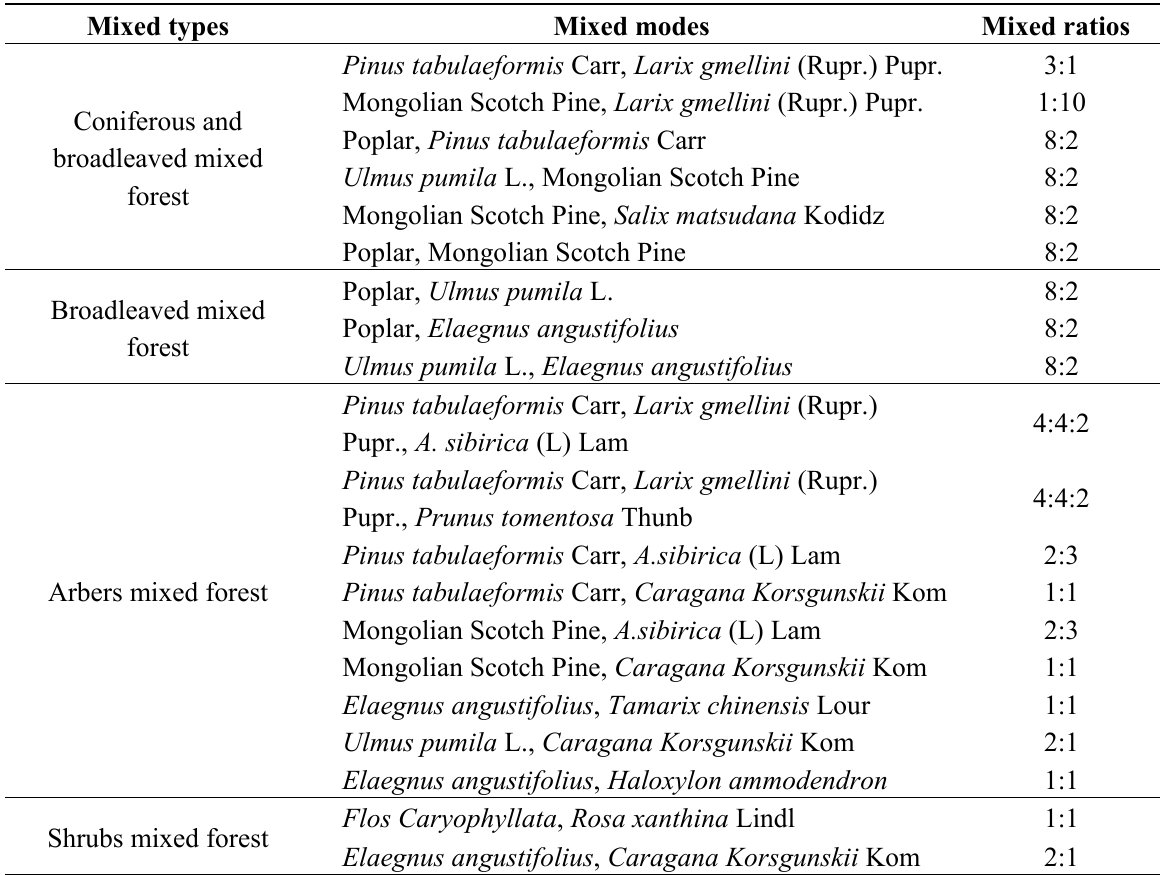
Table 6. Mixed modes and ratios. Mixed modes